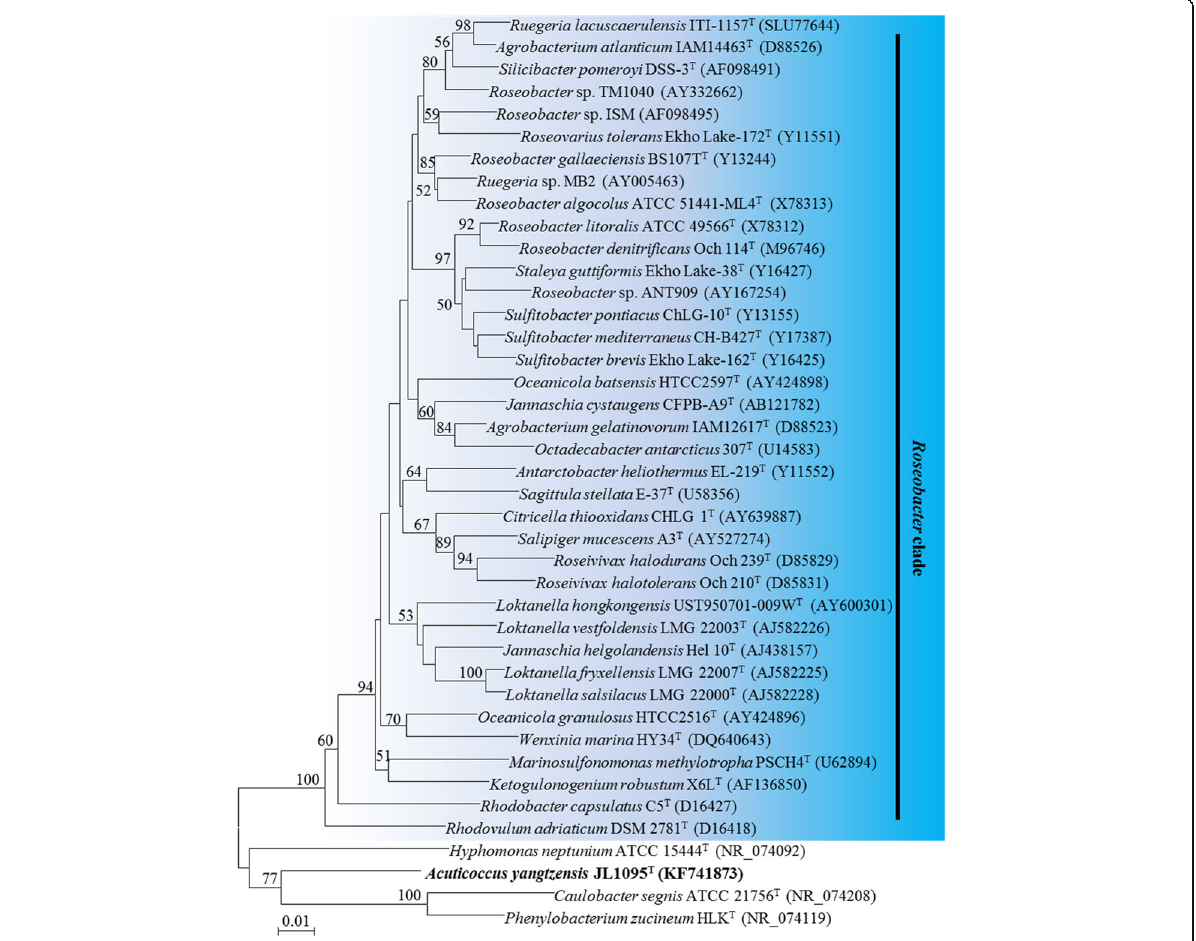
Fig. 4 Unrooted phylogenetic tree displaying the relationship between Acuticoccus yangtzensis JL1095 T and Roseobacter clade bacteria. The tree was constructed with MEGA 5.05 software by using the neighbor-joining (NJ) method based on 16S rRNA gene sequences. Accession numbers in the GenBank database are shown in parentheses. The 16S rRNA gene encoded in the Acuticoccus yangtzensis JL1095 T genome is shown in bold. The numbers at the nodes indicate bootstrap percentages based on 1000 replicates; only values higher than 50% are shown. Bar, 0.01 substitutions per nucleotide